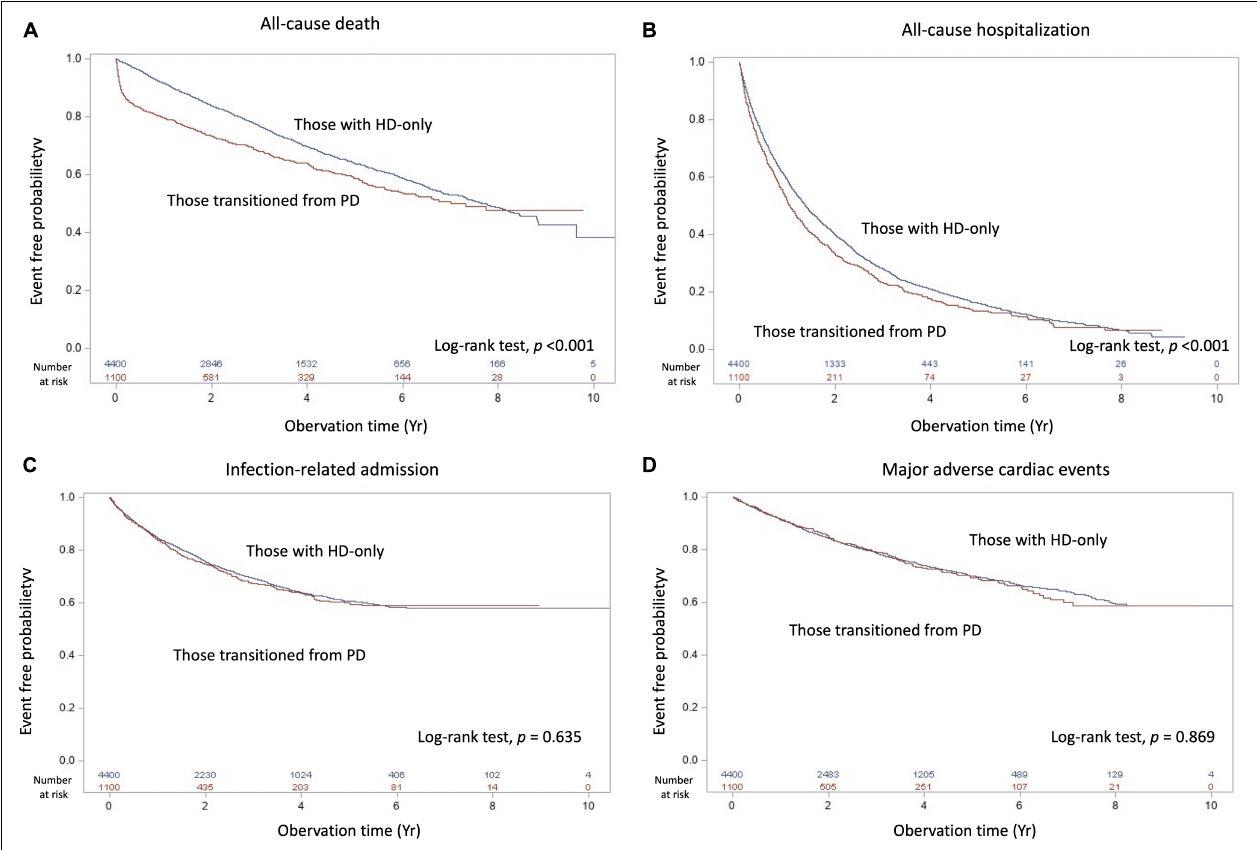
FIGURE 2 | Kaplan–Meier cumulative event-free plots of (A) all-cause death, (B) all-cause hospitalization, (C) infection-related hospitalization, and (D) major adverse cardiac events in the study population based on having experienced peritoneal dialysis; the results of log-rank tests were χ 2 = 33.01 ( p < 0.001), χ 2 = 12.89 ( p < 0.001), χ 2 = 0.22 ( p = 0.635) and χ 2 = 0.03 ( p = 0.869), respectively. Abbreviation: HD, hemodialysis; PD, peritoneal dialysis.